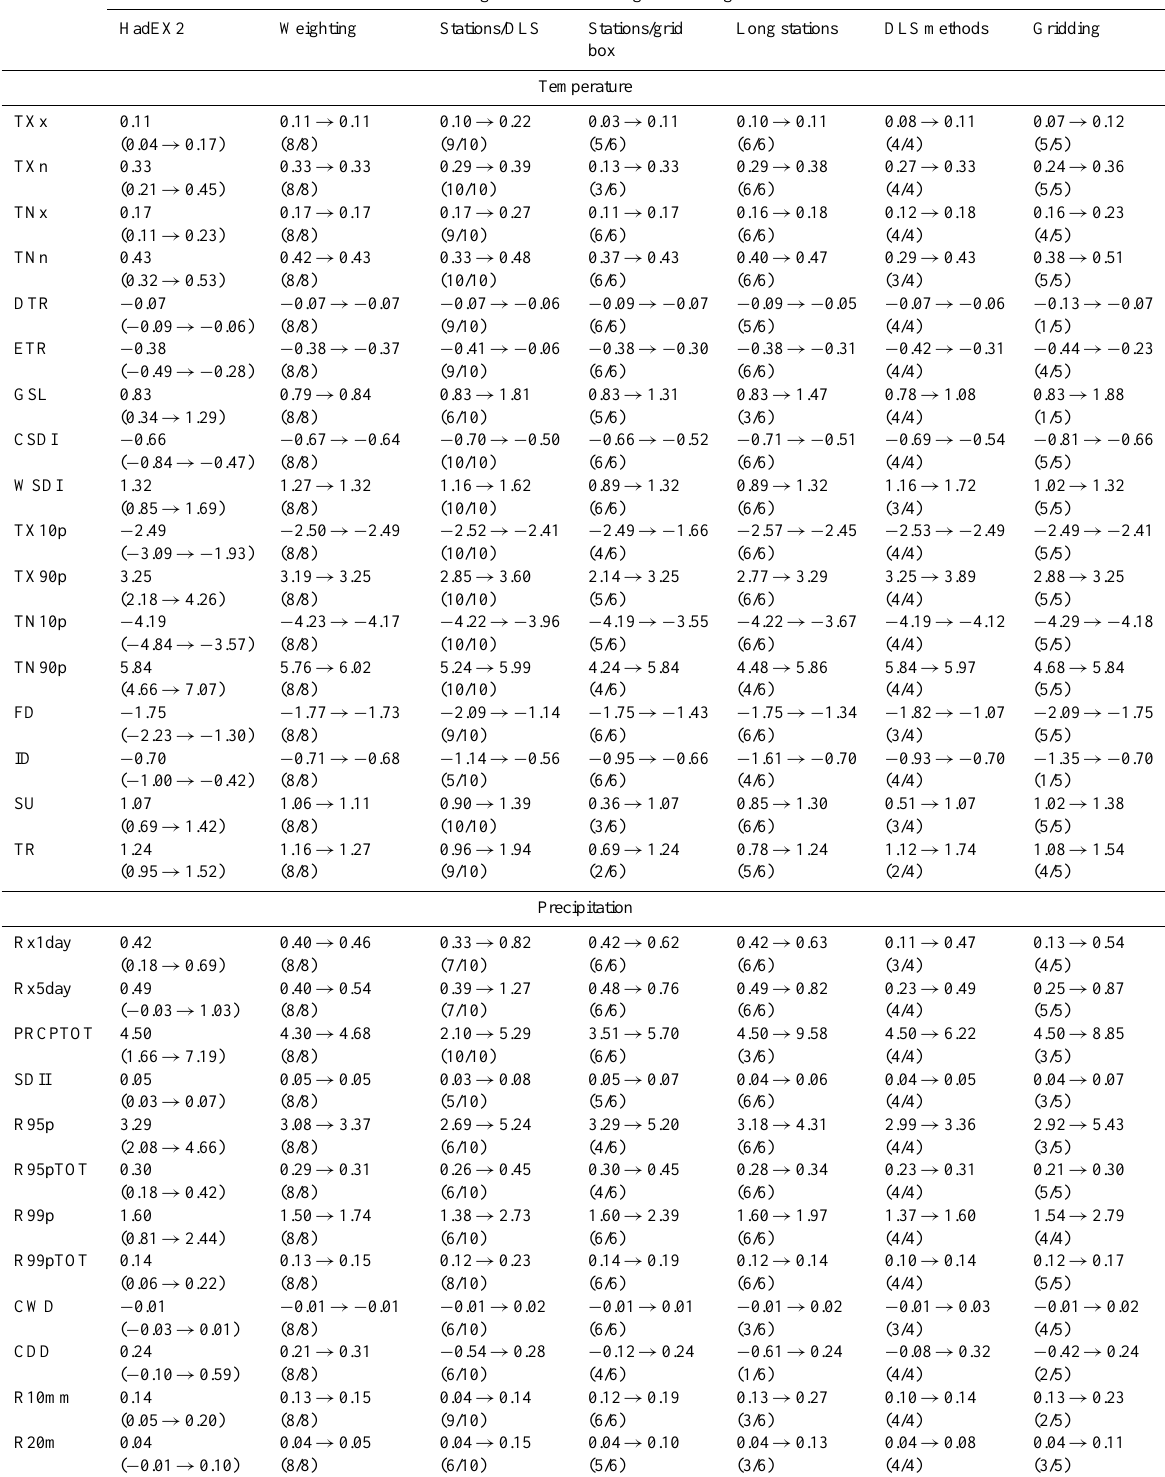
Table 2. A summary of all the uncertainties assessed for each index in this work. For HadEX2, the linear trends and their uncertainties (5th to 95th percentile range) have been calculated over 1951–2010 using the median of pairwise slopes estimator (Sen, 1968; Lanzante, 1996) and are per decade. For the six different choices investigated in this study, the range obtained is shown as well as the number of choices which fall within the statistical range of the HadEX2